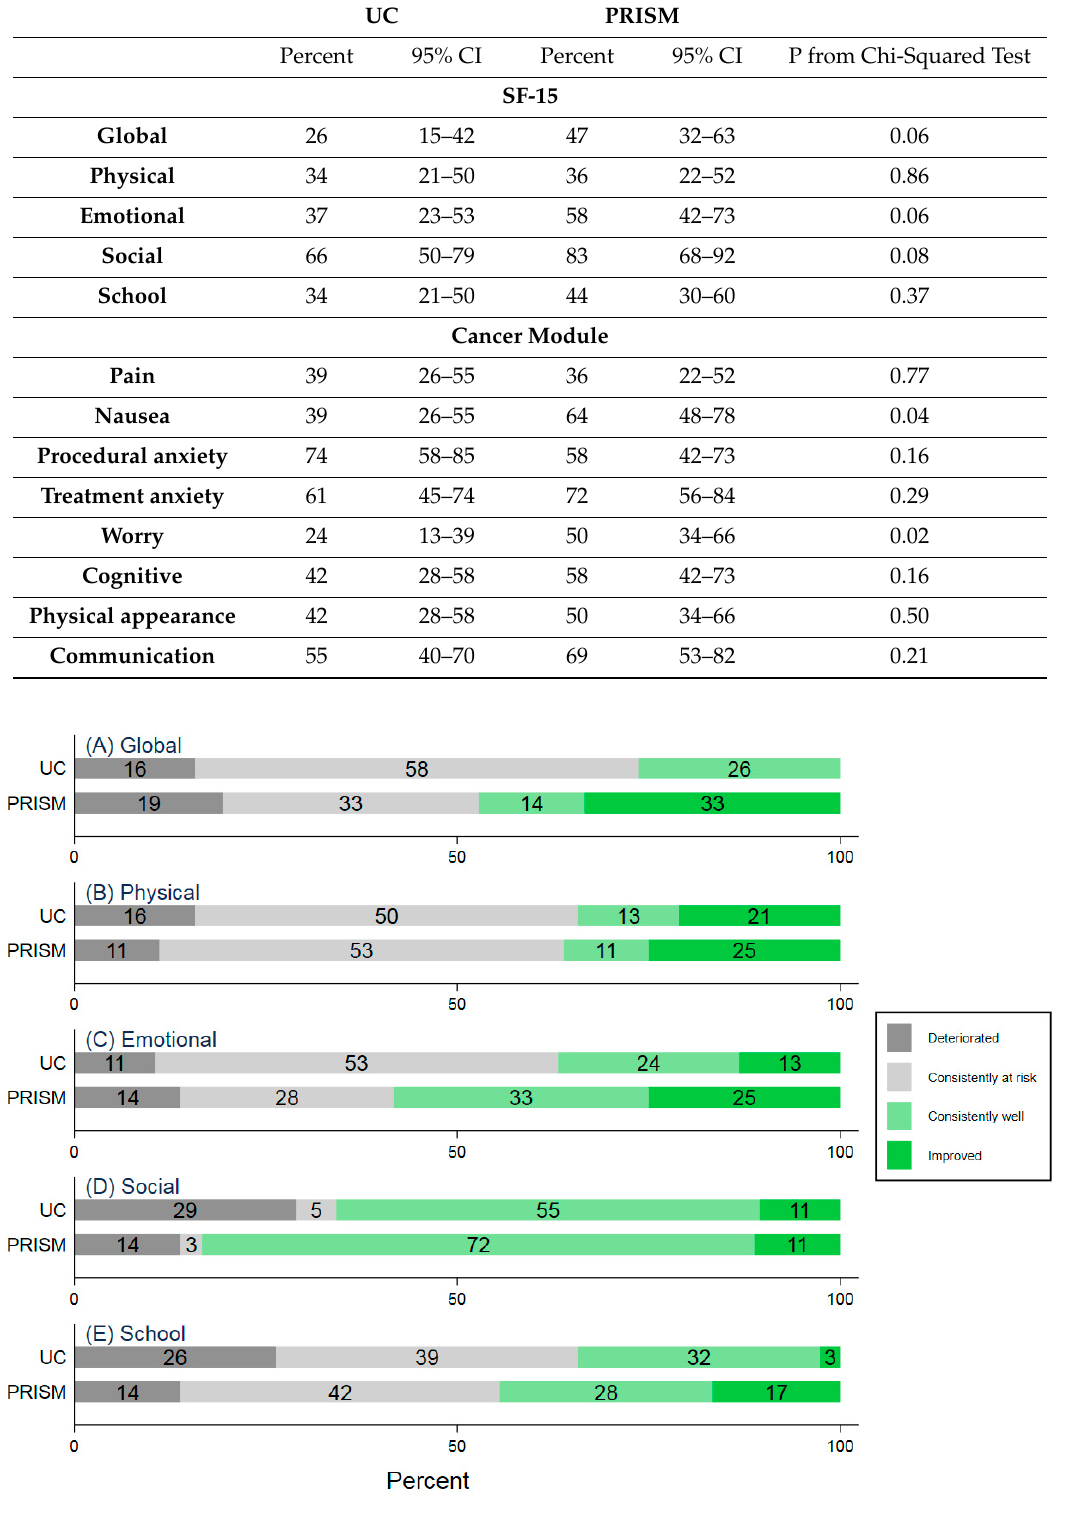
Figure 1. Generic health-related quality of life (HRQOL) trajectories.